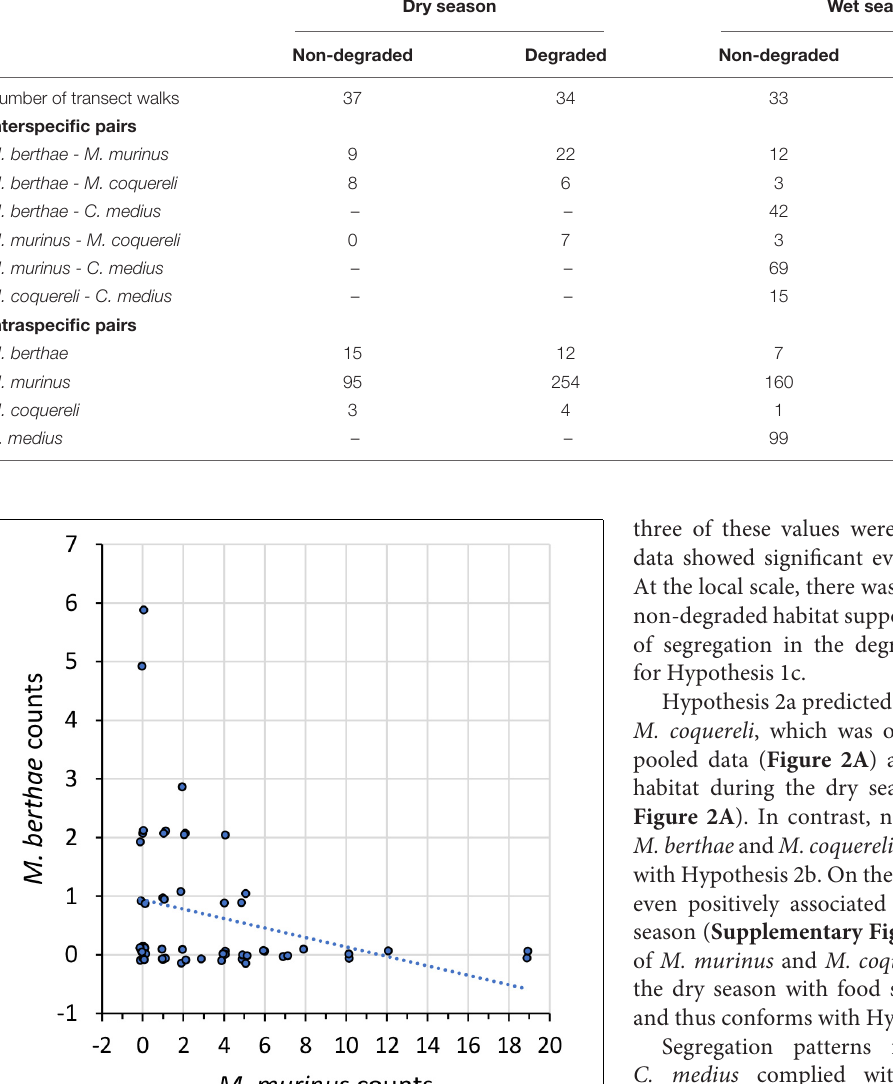
Frontiers in Ecology and Evolution |